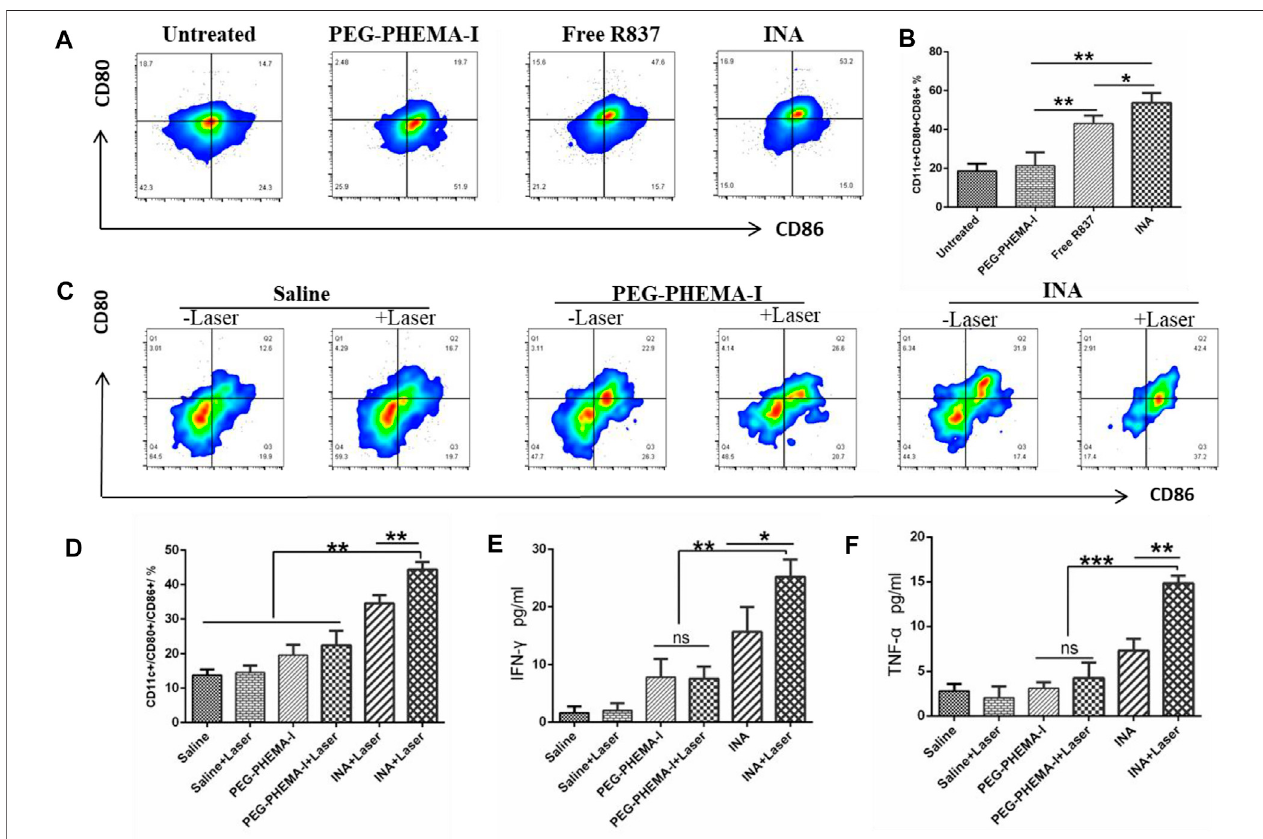
FIGURE5|(A) Flowcytometry ofCD86and CD80 expressions ofDCs after incubation with PEG-PHEMA-I,freeR837, or INA for24 h (B) Quanti fi cation results of fl owcytometryfrom fi gure (A) . (C) FlowcytometryofCD11c,CD80,andCD86expressionofDCsunderdifferenttreatments. (D) Quanti fi cationresultsof fl owcytometry from fi gure (C) (E,F) Cytokine levels of IFN- γ and TNF- α in sera from mice isolated on day 2 post INA-based PDT. Three mice were measured in each group. Error bars represent the standard deviation (SD) of at least three